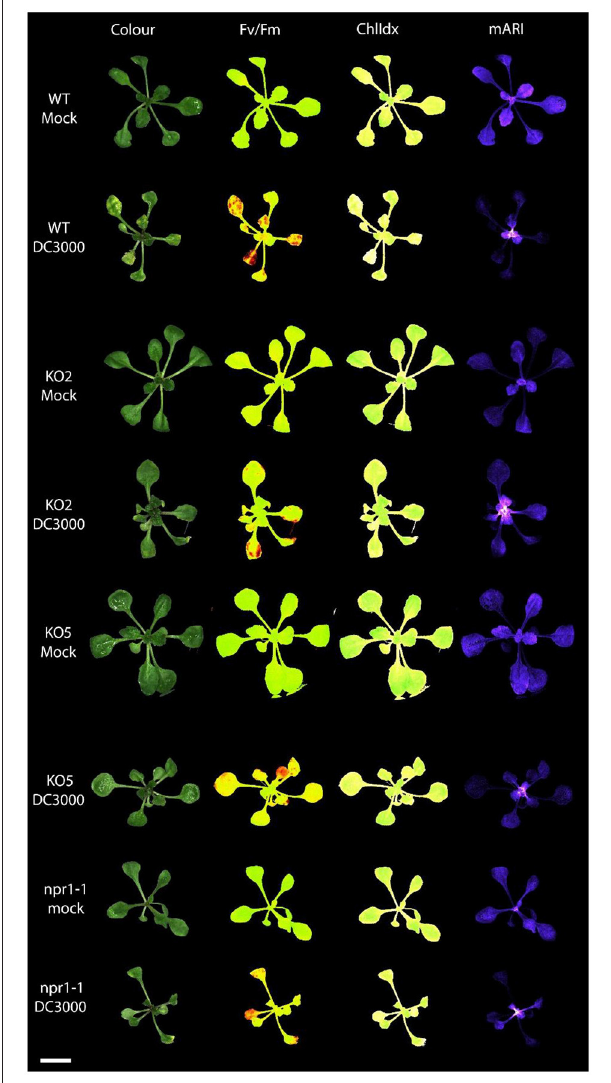
FIGURE 4 | Multispectral images of Arabidopsis rosettes 3 days after mock treatment and Pst DC3000 inoculation. The different images represent the rosette measuring the following traits: RGB Color image; Fv/Fm: efficiency of photosystem II; ChlIdx: chlorophyll index, a measure for the amount of chlorophyll; mARI: modified anthocyanin reflectance index, a measure for the amount of anthocyanin content. Scale bar represents 1cm. F-Box Nictaba Overexpression Line